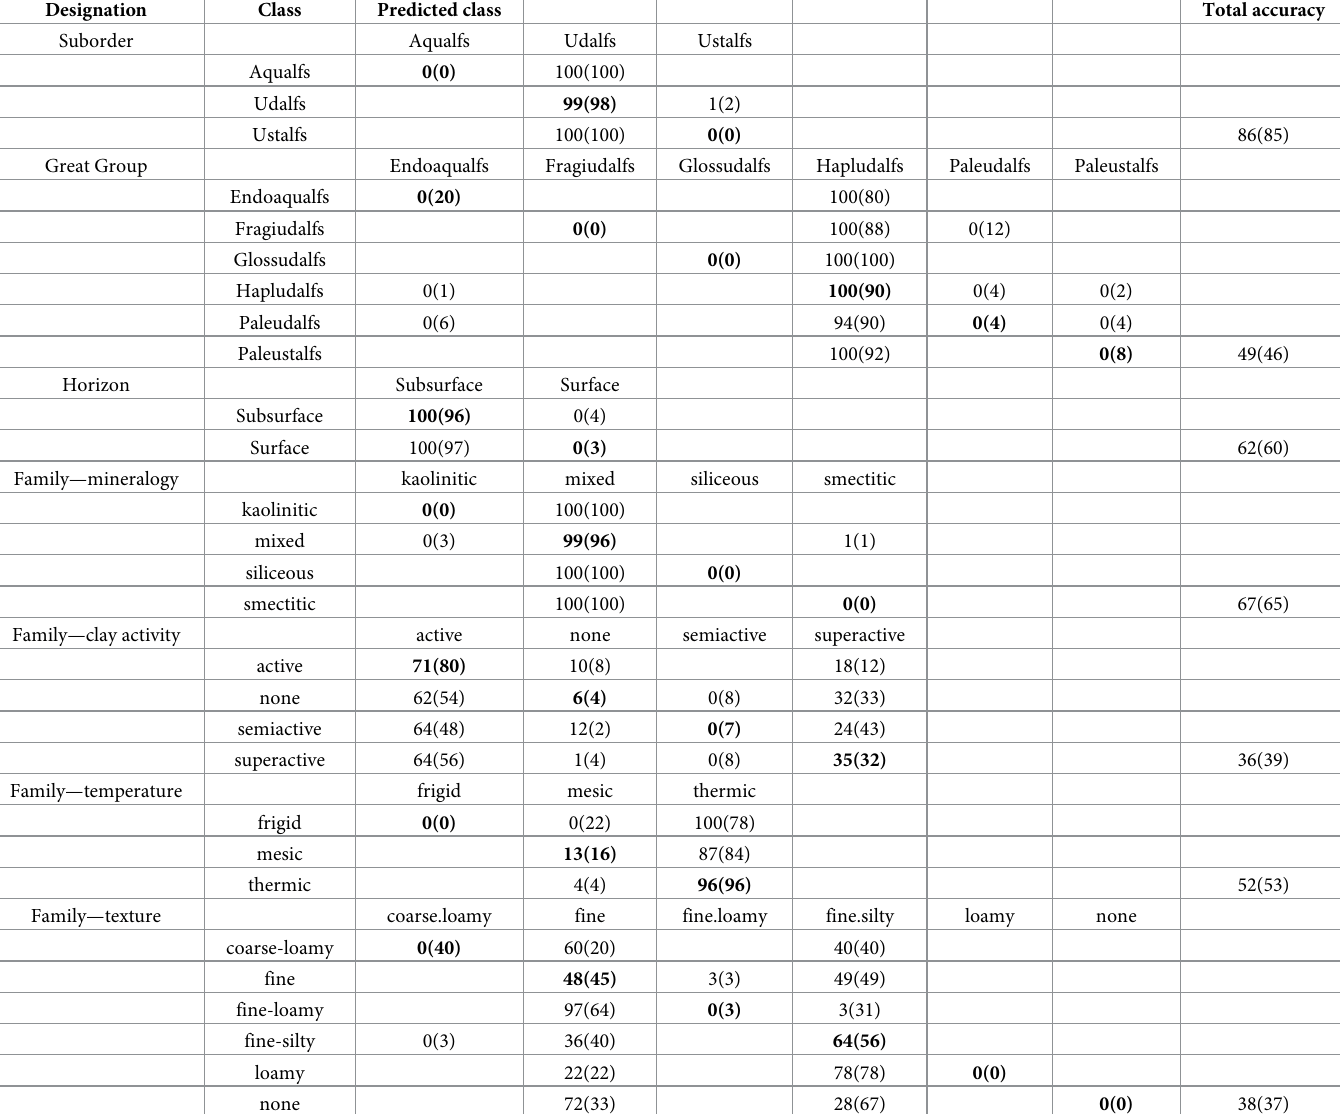
Table 3. Misclassification matrix from linear discriminant analysis testing the accuracy of 2-PCA model used to describe the Mehlich-III extracted (ME) composi- tion and a 3-PCA model for the CEC subcomposition to correctly assign class memberships of the Alfisols samples among the different Great Group taxonomic des- ignations. Percent correct classifications are shown on the diagonal (in bold) while percent misclassification samples are shown off-diagonal. Accuracy of the CEC subcomposition is given in